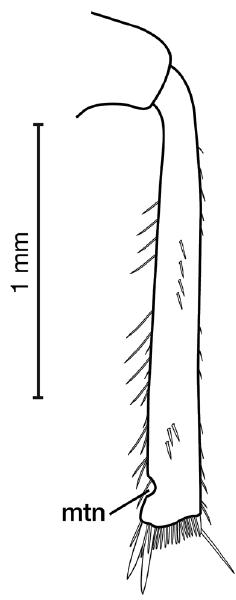
Figure 53. Line drawing of the meso-tibia of C. ( Coptoderina ) proksi Jedlička, showing seta pattern and placement of meso-tibial notch ( mtn